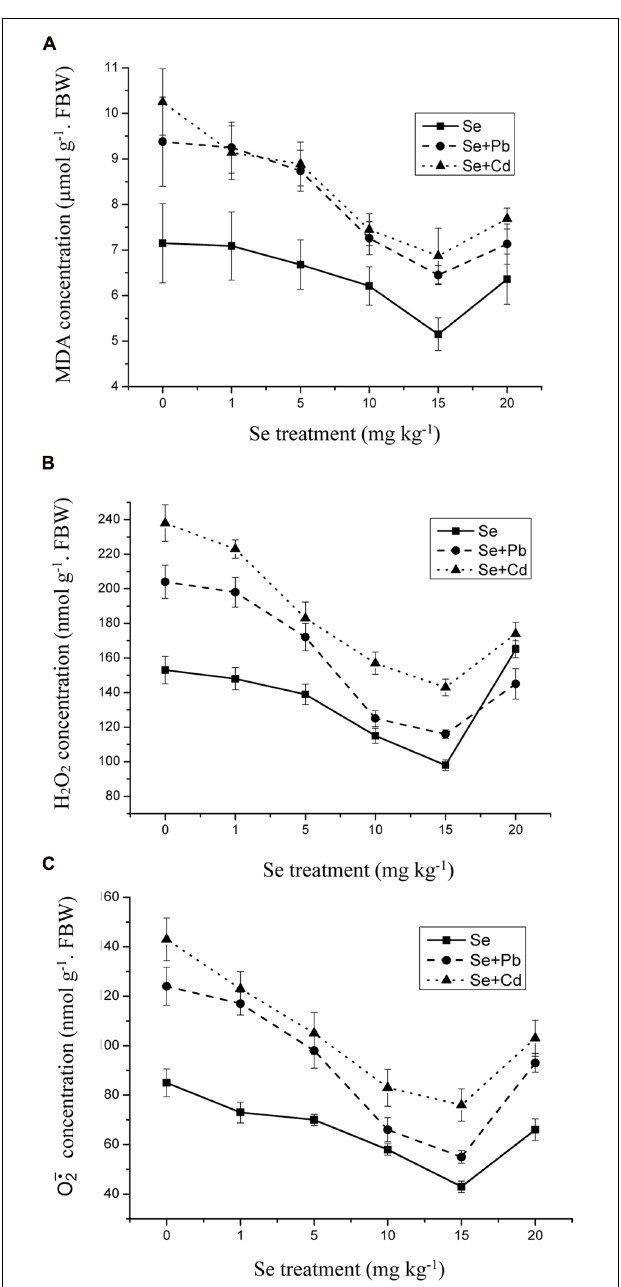
FIGURE 6 | (A) The concentration of malondialdehyde (MDA) in shoots of oilseed rape treated with soil Se, Se + 5Cd, or Se + 500Pb after a planting time of 60 days. (B) The concentration of hydrogen peroxide (H 2 O 2 ) in shoots of oilseed rape treated with soil Se, Se + 5Cd, or Se + 500Pb after a planting time of 60 days. (C) The productive rate of superoxide anion (O ¯• 2 ) in shoots of oilseed rape treated with soil Se, Se + 5Cd, or Se + 500Pb after a planting time of 60 days. Average values (Fresh biomass weight, FBW) provided with error bars representing the standard error. ( p ≤